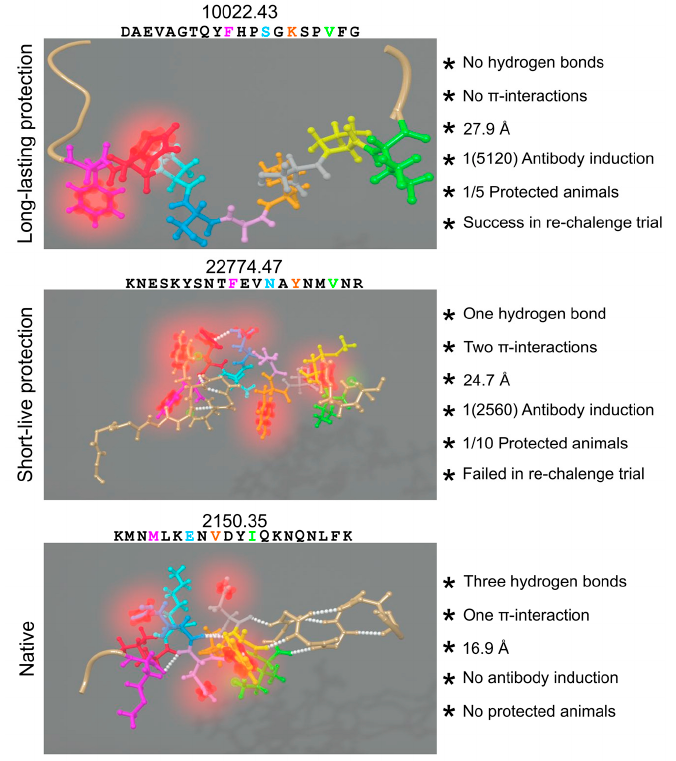
Figure 5. Intramolecular forces' influence: the peptide’sequence and 3D-structure is shown on the left, represented by balls and sticks. Residues, fitting into HLA-DR β PBR coloured the same as in Figure 3: H-bonds in white spheres, π -systems in blurred red and interacting hydrogens in blurred green. Structural and immunogenic features of the nine residues from cHABPs and mHABPs interacting with the PBR are shown on the right. Figure based and adapted from [253]. Reproduced with permission from Patarroyo ME, Biochem. Biophys. Res. Commun. ; published by Elsevier, 2017.